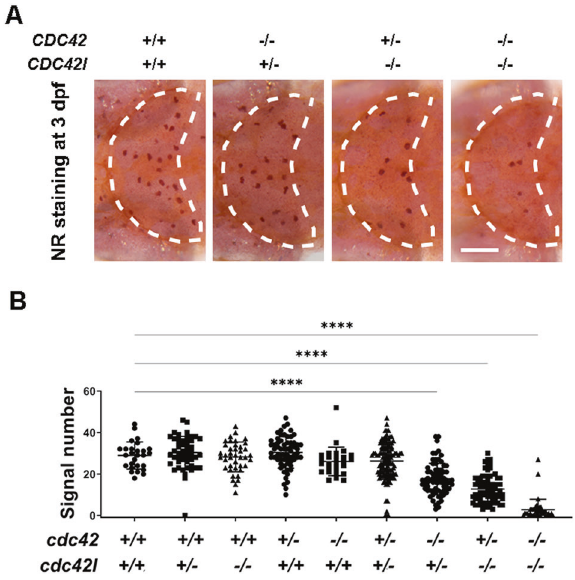
Fig. 6 dock8 affect microglia colonization in zebra fi sh early larvae via cdc42 . A Representative image of NR staining in cdc42 -20bp cdc42l − 29bp double mutants at 3 dpf. B Quanti fi cation of NR signals in cdc42 − 20bp cdc42l − 29bp double mutants at 3 dpf. Group sizes were at least n = 48 zebra fi sh embryos. Each dot represents one larva. White dashed lines indicate the optic tectum. Scale bar = 100 µm. Data were analyzed by one-way ANOVA followed by Dunnett ’ s multiple comparisons test. **** P ≤ 0.0001